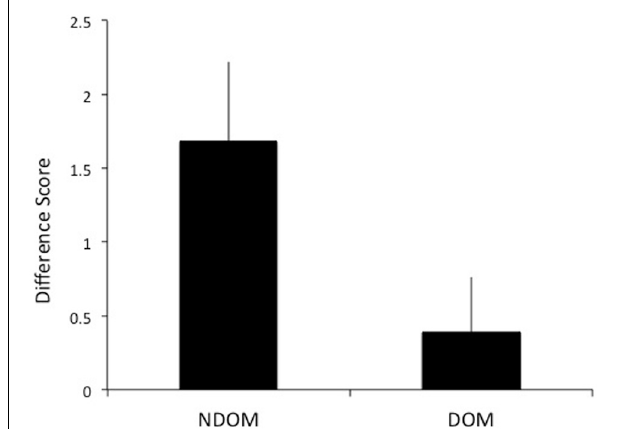
FIGURE 5 | Subjects who trained on the nondominant hand (NDOM) showed greater intermanual transfer of learning than those trained on the dominant hand (DOM), as indicated by higher difference